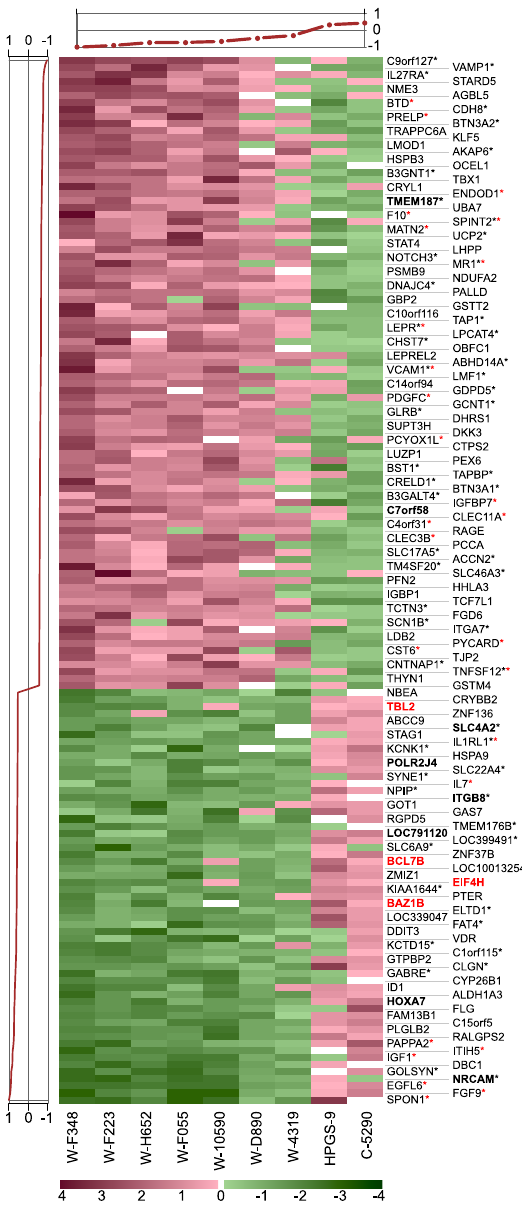
Figure 2. Example of a WBS dysregulated module ( # 770 from the M2 module set). This module contains 149 genes (one per line) and 9 samples (columns). Seven samples are from WBS patients (denoted with ‘‘W’’), C-5290 is a control sample from our dataset, while HPGS-9 belongs to a publicly available dataset. Gene scores are plotted on the left and sample scores at the top. The 59 genes with positive gene scores (bottom lines) are downregulated (green) in the seven WBS samples and upregulated (red) in the other two. The remaining 90 genes show the opposite pattern: they are upregulated in the WBS samples and downregulated in the remaining two samples. Hemizy- gous gene names are emphasized in red and the names of genes mapping to HSA7 in boldface. Red asterisks indicate genes belonging to the GO category ‘‘extracellular region’’ while black asterisks denote genes from the ‘‘intrinsic to membrane’’